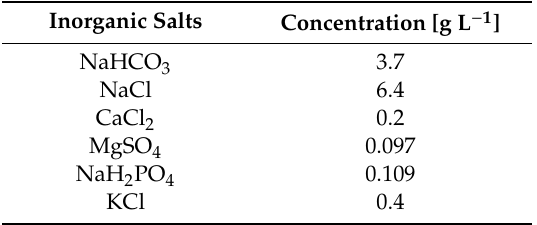
Table 1. Ion content of the Dulbecco’s modified Eagle’s medium (DMEM) cell culture